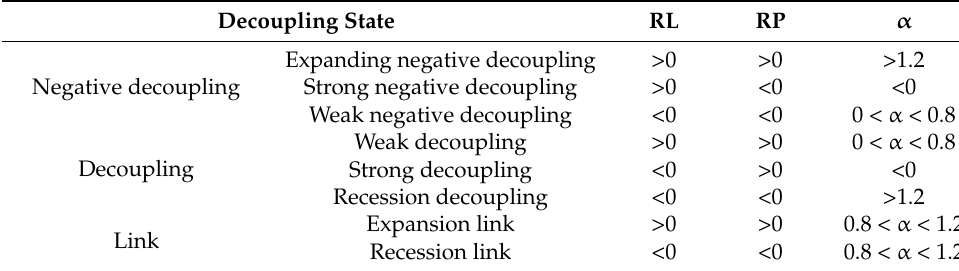
Table 1. Definition of the decoupling